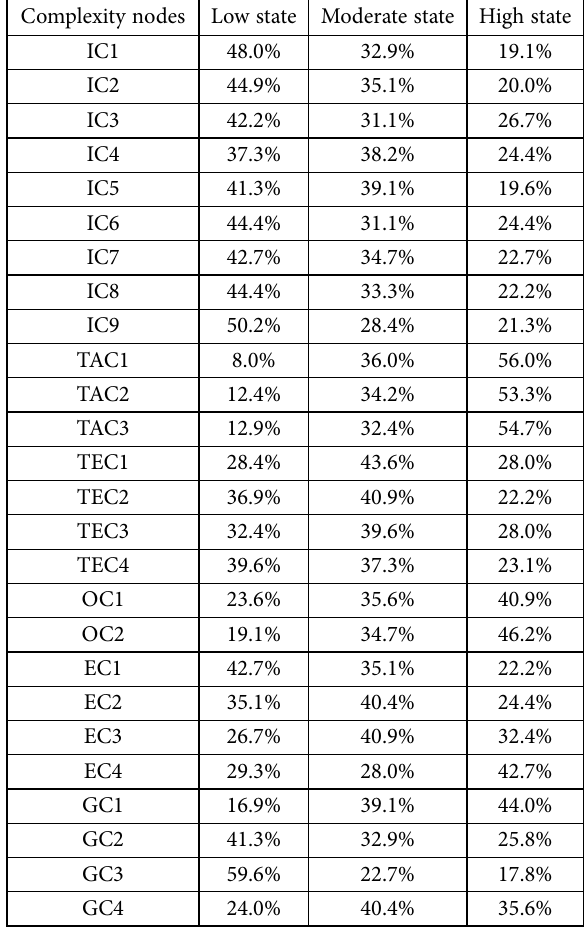
Table 3. Statistical distribution of complexity nodes under different